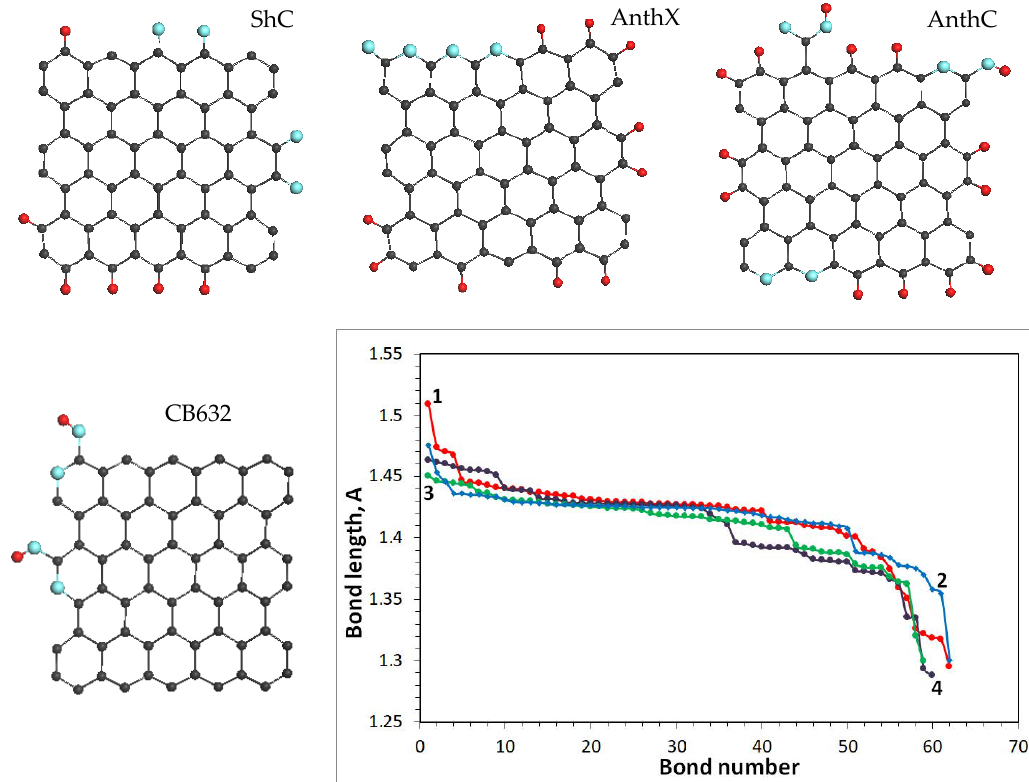
Figure 5. Equilibrium structure of BSU models related to shungite carbon (1), anthraxolite (2), anthracite (3), and carbon black CB632 (4). Distribution of C = C bond lengths of the model graphene cores. UHF AM1 calculations.